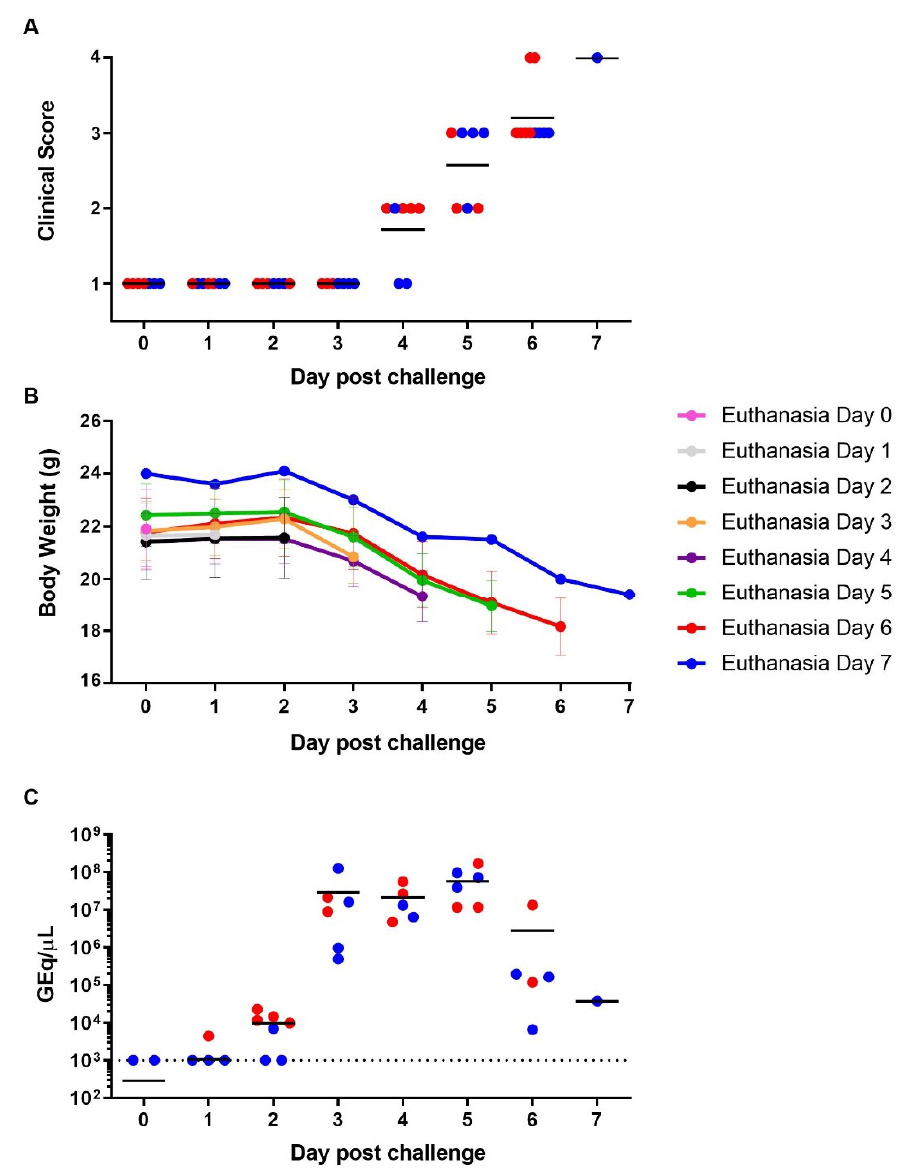
Figure 3. Clinical Scoring, Weight Loss, and Viremia following SUDV Challenge in STAT-1 KO Mice. Individual clinical scores ( A ) and mean body weights grouped by euthanasia day ( B ) were recorded over time. The levels of viral RNA in serum were measured at the time of euthanasia and are presented in genome equivalents per µL (GEq/µL; C ). Symbols ( • and • ) represent individual values from a female or male mouse, respectively. The dotted line indicates the limit of detection of the assay (1 × 10 3 GEq/µL or approximately 6 pfu/mL). Horizontal and vertical bars indicate means and stand- ard errors, respectively.